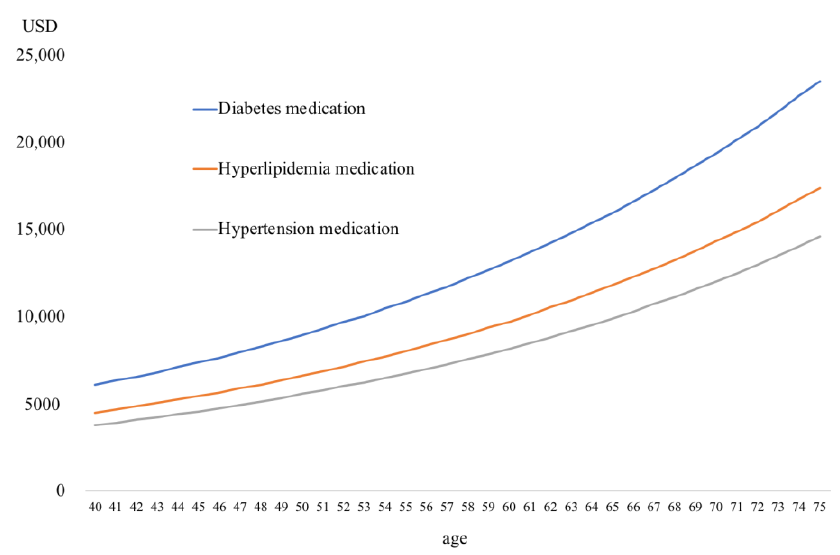
Figure 2. Five-year cumulative outpatient and medication expenditure for men by medication type. Int. J. Environ. Res. Public Health 2020 , 17 , x